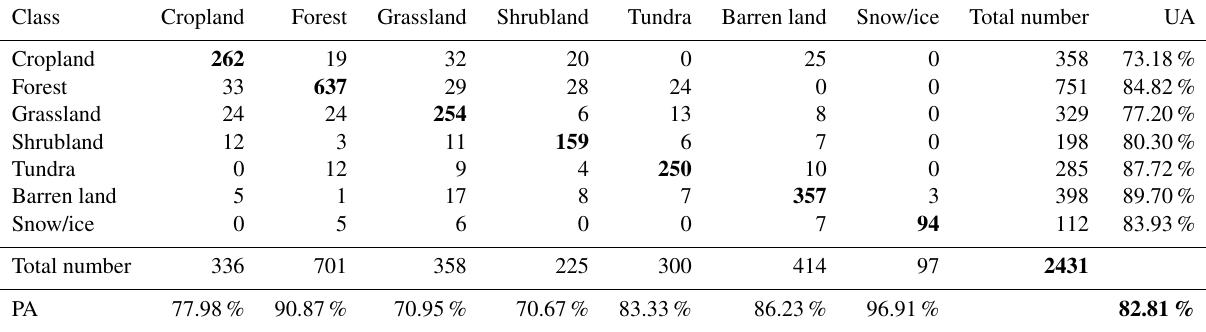
Table 6. Classification accuracy of GLASS-GLC (annual dynamics of global land cover) with change detection under independent test samples (overall accuracy = 82 . 81%; UA denotes user’s accuracy, and PA denotes producer’s accuracy). Bold numbers represent correctly classified